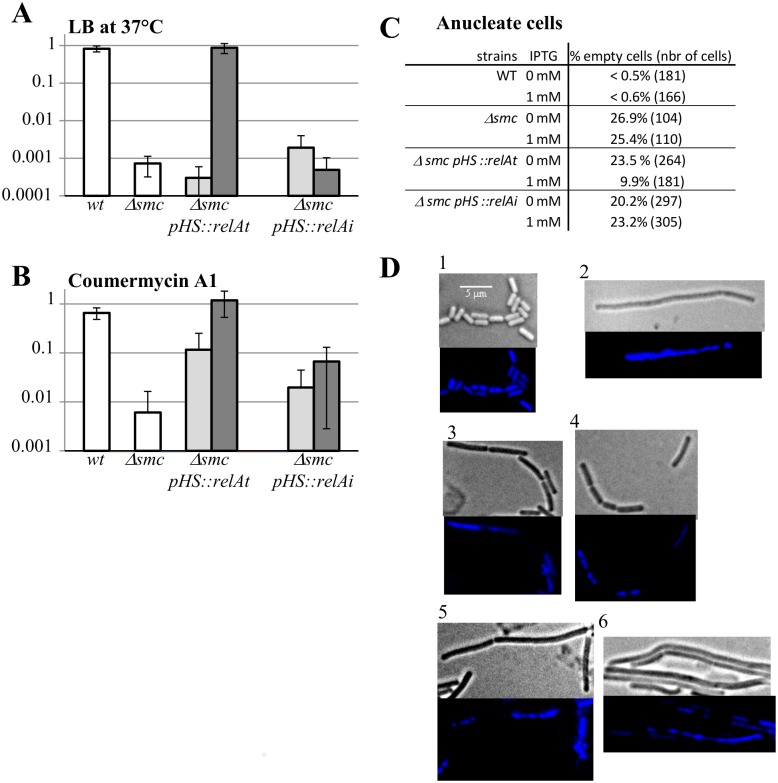
Restoration of Δsmc viability by inducible expression of relA.
Δsmc cells carrying different alleles of the E. coli relA genes either as an inactive form (relAi) either as a truncated form (relAt) under the transcriptional control of the Phyperspank promoter were grown in permissive condition (LB at 23°C) with or without IPTG 1mM. Cells were then diluted, spread on both LB plates and LB plates containing IPTG and incubated at permissive (23°C) and non permissive temperature (37°C) for 48h or on coumermycinA1 (1μg/ml) at 23°C. For each condition the ratio of cells growing in non permissive condition versus the number of cells grown in permissive condition (panels A and B) was calculated. The results are the means and the standard deviation measured on at least five different clones. Cells grown at 37°C were also analyzed by microscopic observation after DAPI treatment in order to calculate the ratio of anucleate cells (panel C) and to illustrate the condensation phenotype of the DNA in the WT strain (panel D1), Δsmc (panel D2), ΔsmcPhyperspank::relAt (panel D3), ΔsmcPhyperspank::relAt with 1mM of IPTG (panel D4), ΔsmcPhyperspank::relAi (panel D5), ΔsmcPhyperspank::relAi with 1mM of IPTG (panel D6).